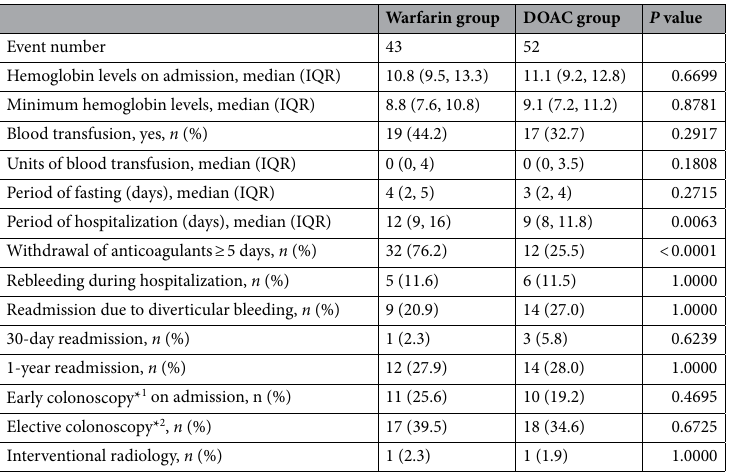
Table 3. Comparison of the clinical outcomes of patients taking warfarin vs. DOAC. * 1 A colonoscopy was performed within 24 h of the initial visit. * 2 A colonoscopy was performed more than 24 h after the initial visit but prior to